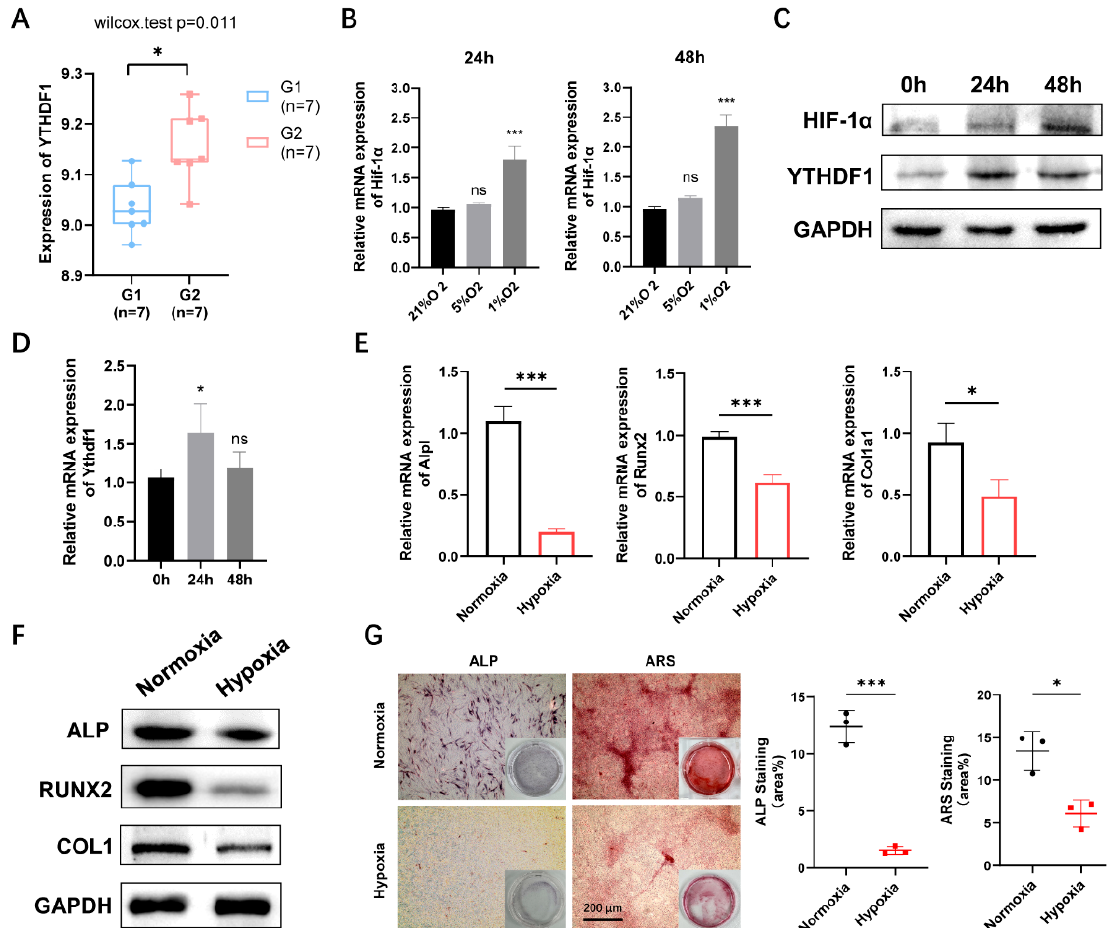
Figure 1. Hypoxia-induced osteogenesis downregulation and YTHDF1 promotion in MC3T3-E1 cells. ( A ) The gene expression profile dataset GSE33774 in GEO was selected to evaluate the differential expression of YTHDF1 in normal groups ( G1 ) and peri-implantitis groups ( G2 ). ( B ) The expression of Hif-1a at different O 2 concentrations (21%, 5%, 1%) for 24 h and 48 h were determined by qRT-PCR. ( C ) The protein expression of HIF-1 α and YTHDF1 at 1% O 2 concentrations at different time points by Western blot. GAPDH was used as the internal control. ( D ) The mRNA expression of YTHDF1 under 1% O 2 concentration conditions at different time points. ( E ) mRNA expression of osteogenic differentiation-related marker genes including Alp l, Runx2 , and Col1a1 under hypoxic treatment. ( F ) Protein level of ALP, RUNX2, and COL1 under hypoxia was verified by Western blot. ( G ) ALP staining and ARS staining showed reduced osteogenic ability in MC3T3-E1 cells under hypoxic conditions. Scale bar, 200 μ m, n = 3. Results are presented as mean ± SD, Student’s t -tests, and one-way ANOVA followed by Tukey’s test (ns: not significant, * p < 0.05, *** p < 0.001, compared with the control group). YTHDF1, Yth m 6 A RNA-binding protein 1; HIF-1 α , hypoxia-inducible fac- tor-1 α ; ALP, alkaline phosphatase; RUNX2, runt-related transcription factor 2; COL1, type 1 colla- gen; ARS, alizarin red staining.